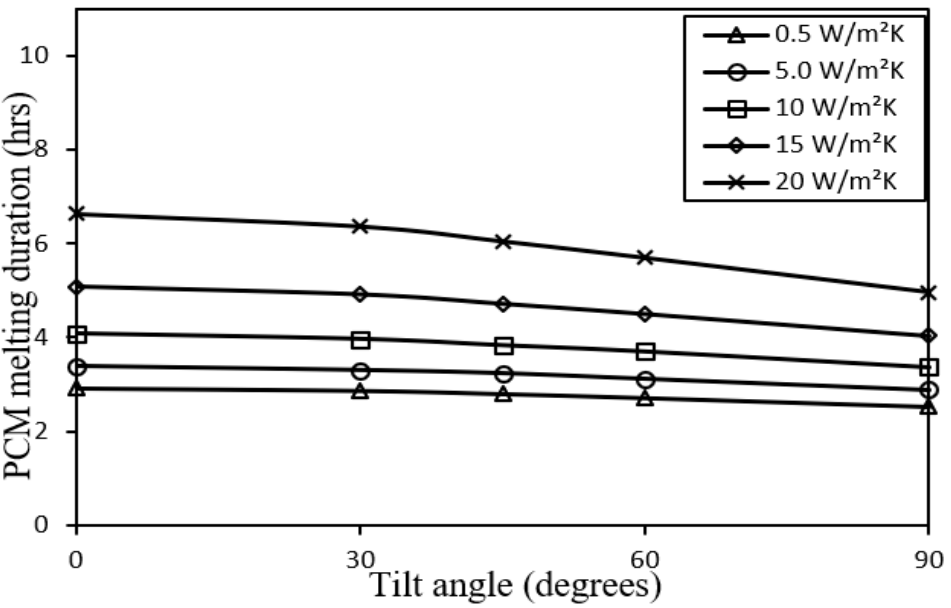
Figure 11. Impact of tilt angle on PCM melting duration for different metal foam convective heat transfer coefficients.